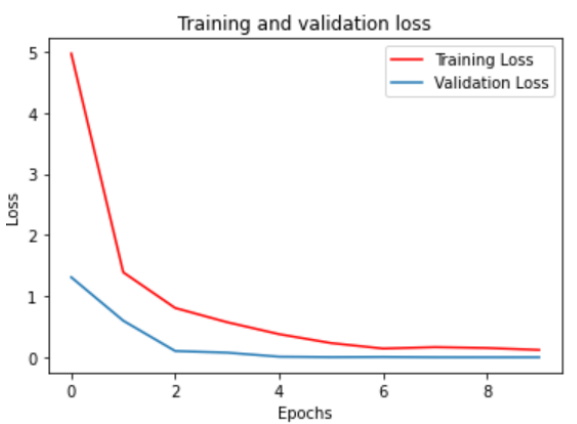
Figure 5. Training and validation loss